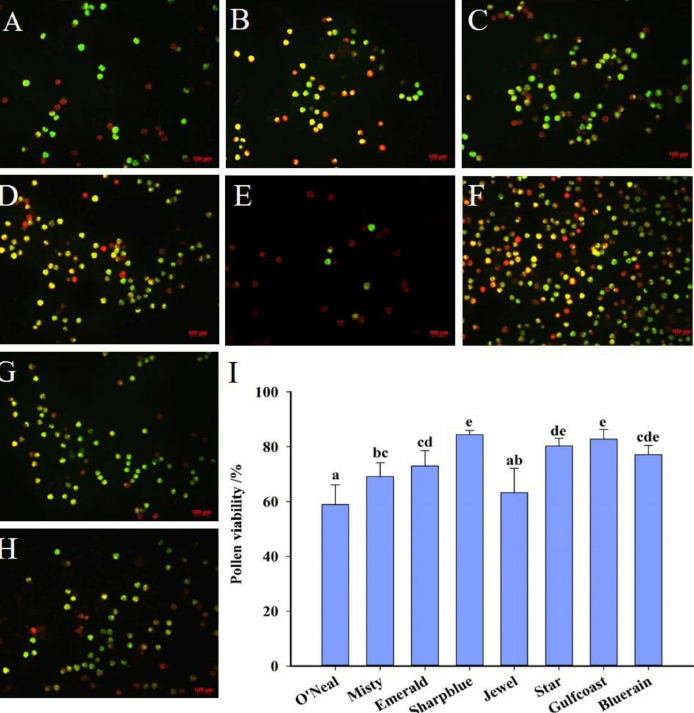
Figure 2. Southern highbush blueberry (SHB) pollen viability tested by FDA–PI. ( A ) ‘O’Neal’; ( B ) ‘Misty’; ( C ) ‘Emerald’; ( D ) ‘Sharpblue’; ( E ) ‘Jewel’; ( F ) ‘Star’; ( G ) ‘Gulfcoast’; ( H ) ‘Bluerain’. Bar: A to H = 100 µ m. ( I ) Pollen viability of SHB cultivars. The X-axis indicates different blueberry cultivars. Bars with different letter superscripts are significantly different from each other at the p < 0.05 level using the Duncan’s